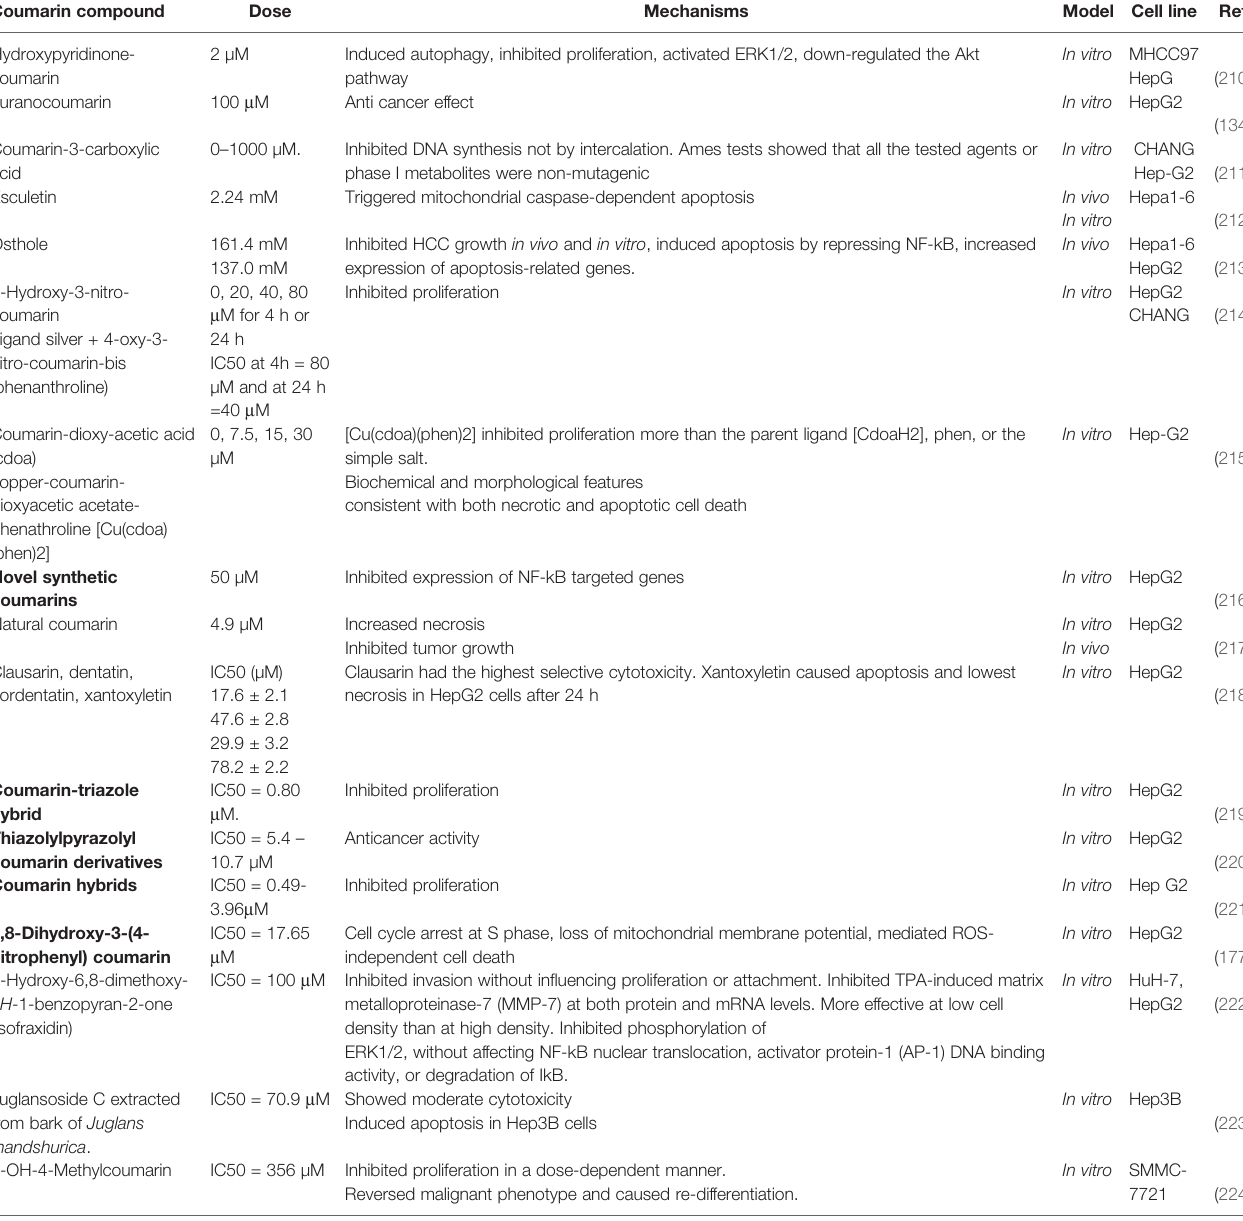
TABLE 4 | Anti-hepatocellular cancer effects of